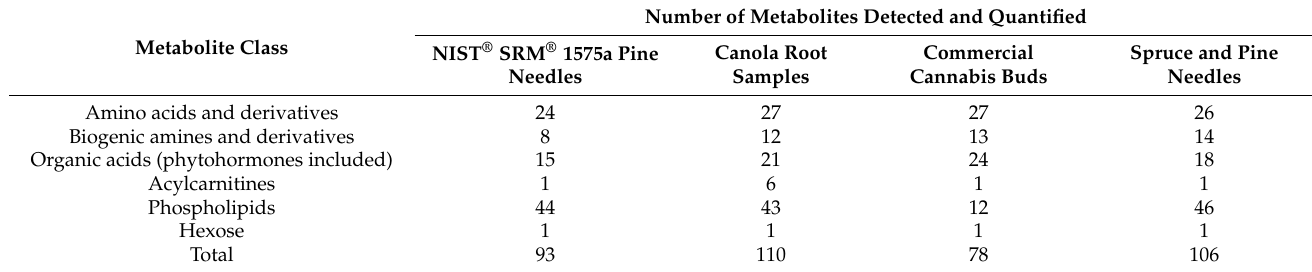
Table 6. Summary of Metabolite Numbers Detected and Quantified in Different Plant Types.